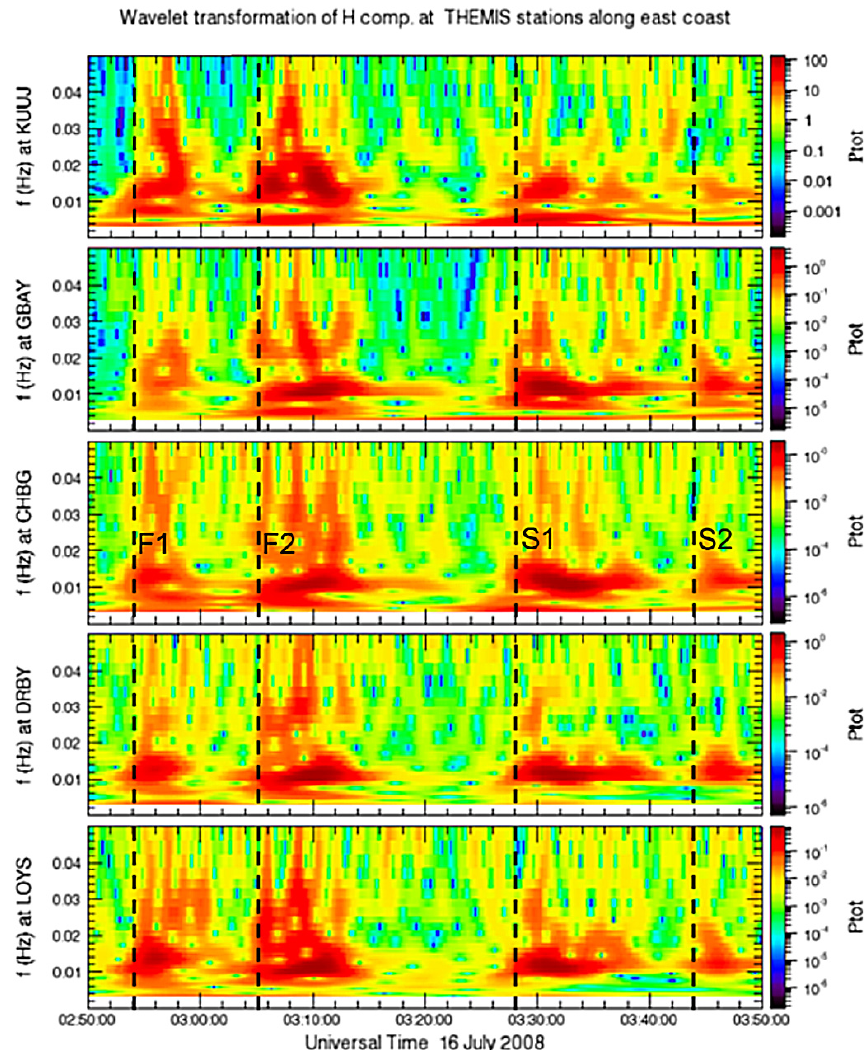
Fig. 4. The wavelet transformation of the H-component at the THEMIS ground stations along the East Coast of North America from 02:50UT to 03:50UT on 16 July 2008. The vertical dashed lines denote ground Pi2